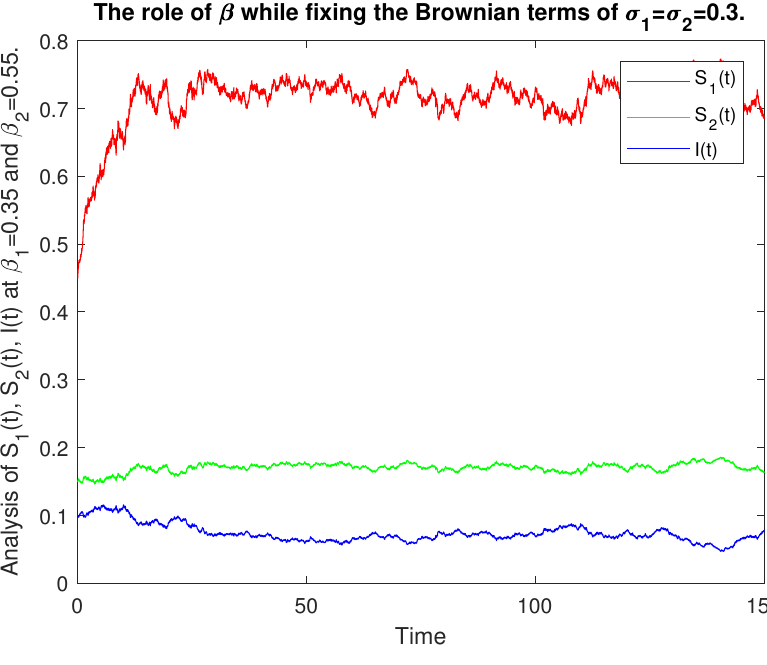
Figure 11. Comparative analysis of S 1 ( t ) , S 2 ( t ) , I ( t ) for β 1 = 0.35, β 2 =